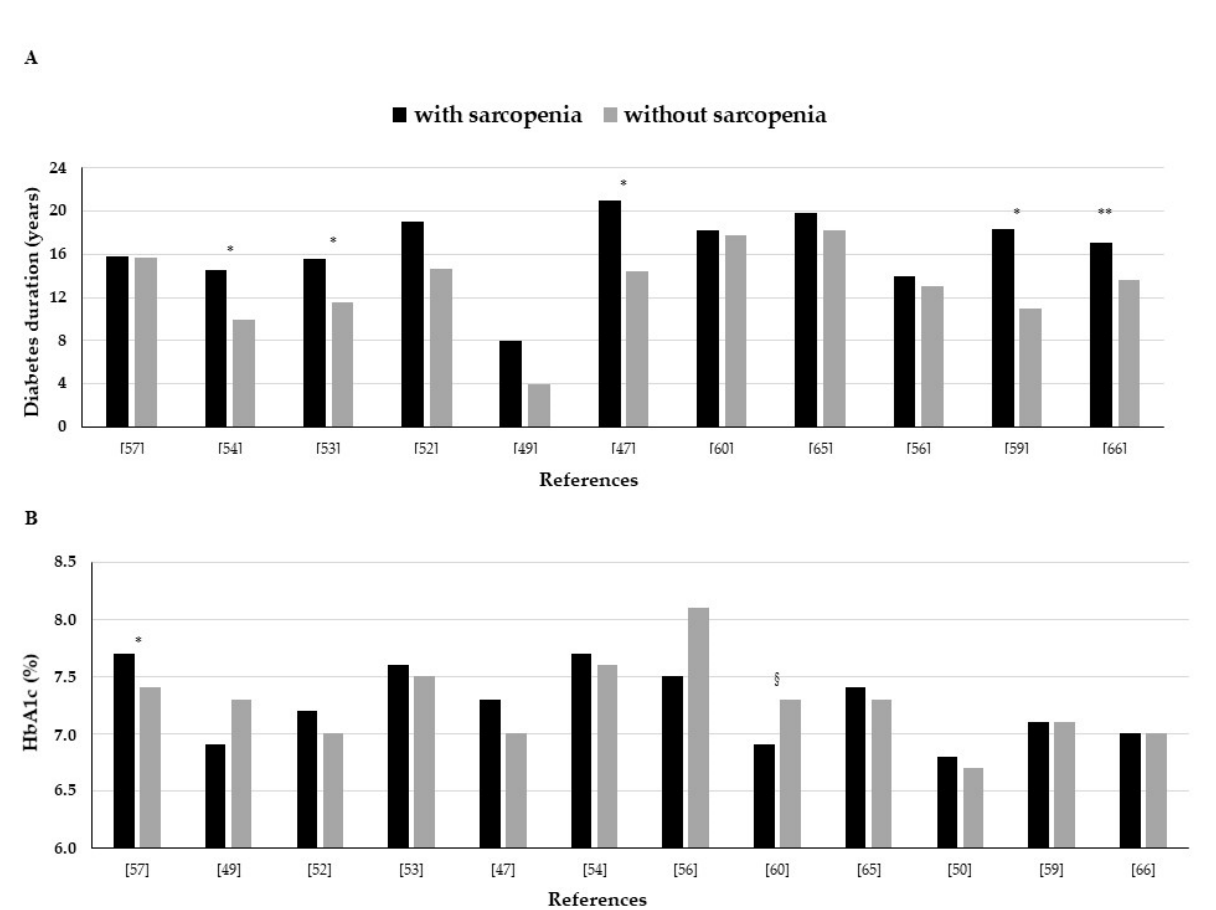
Figure 2. Mean values of diabetes duration ( A ) and glycated hemoglobin ( B ) in type 2 diabetes mellitus individuals with and without sarcopenia in epidemiological studies. * p < 0.05; ** p < 0.001; § p < 0.05 in men.